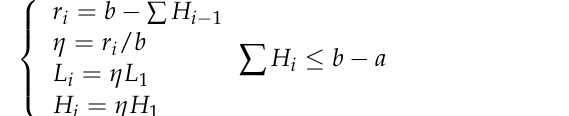
Figure 10. Pentamode material acoustic stealth cloak material laying unit. Table 1. Parameter distribution of pentamode materials in each layer.